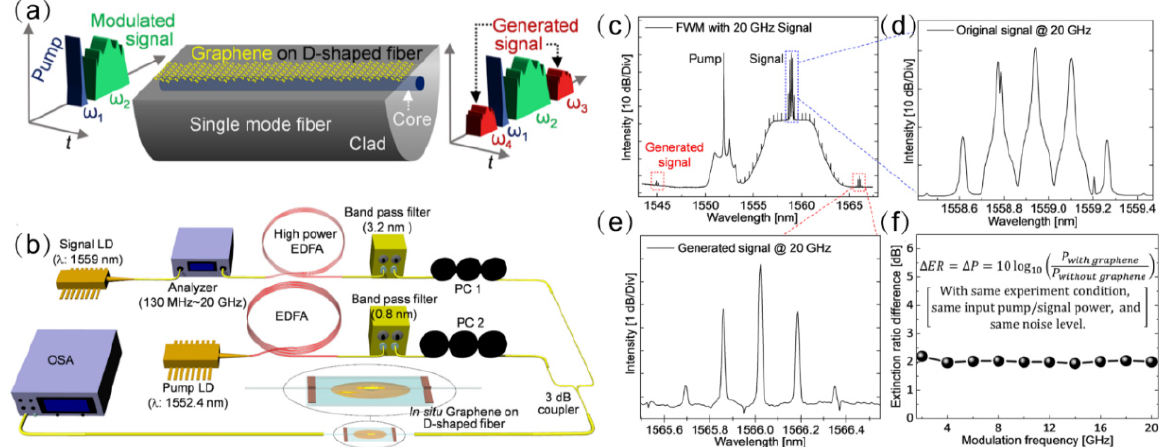
Figure 10. All-optical modulator based on nonlinear four-wave mixing. ( a ) Principle diagram of FWM process by a gra- phene-coated D-shaped fiber, showing two newly generated signals ( ω 3 and ω 4 ) arising from the FWM effect. ( b ) Exper- iment setup. ( c ) Measured FWM spectrum under 20 GHz input signal. ( d ) Close-up view of the original signal with a modulation frequency of 20 GHz. ( e ) Close-up view of generated signal exhibiting a modulation frequency of 20 GHz (same as the original signal). ( f ) Extinction ratio difference ( Δ ER) at different modulation frequency [131]. Copyright 2018, American Chemical